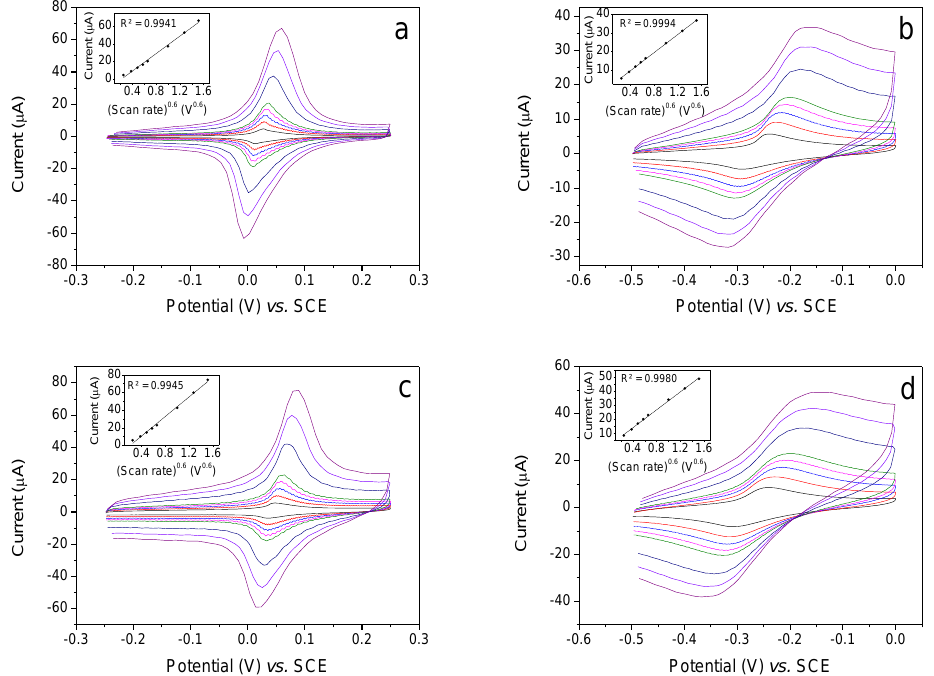
Figure 2. Cyclic voltammograms of ( a ) ferrocenyl polycyclosiloxane polymers FPP ( Γ = 3.4 × 10 − 10 mol Fc cm − 2 )) and ( b ) MFPP ( Γ = 3.4 × 10 − 10 mol Fc cm − 2 ), ( c ) Pt nanoparticles (PtNPS)/FPP ( Γ = 4.2 × 10 − 10 mol Fc cm − 2 ), and ( d ) PtNPs/MFPP ( Γ = 3.6 × 10 − 10 mol Fc cm − 2 ) modified electrodes in acetonitrile/tetra-n-butylammonium hexafluorophosphate (TBAH) (0.1 M); scan rates: 0.1, 0.2, 0.3, 0.4, 0.5, 1, 1.5 and 2 V/s. Insets: Dependence of the corresponding anodic peak currents on v 0.6